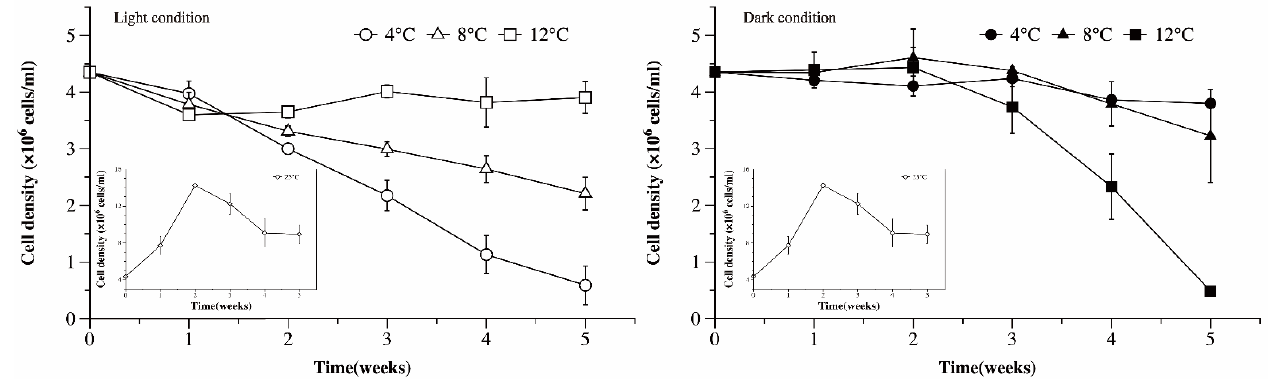
Figure 1. The cell density dynamics of Ma under different temperature and light conditions, as a function of time: Inserts — the control group: The cell density dynamics of Ma under 25 °C and light condition.